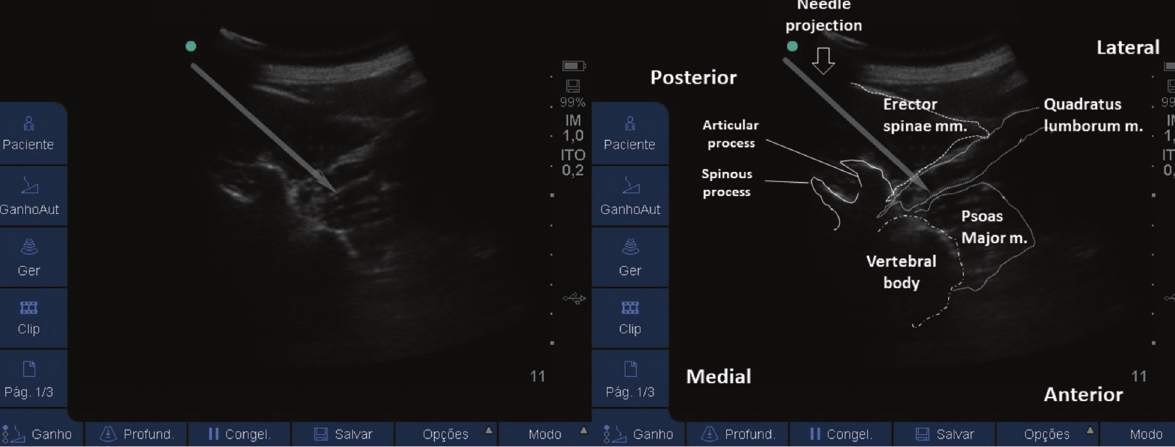
Figure 19 - US image of the transducer in the lateral position, medially tilted, with a view of the lateral aspect of the vertebrae. To perform the block, the needle may be advanced from posterior to anterior (as the above image) or from lateral to medial. Its tip must cross the QL muscle and be located in the plane between the QL and PM